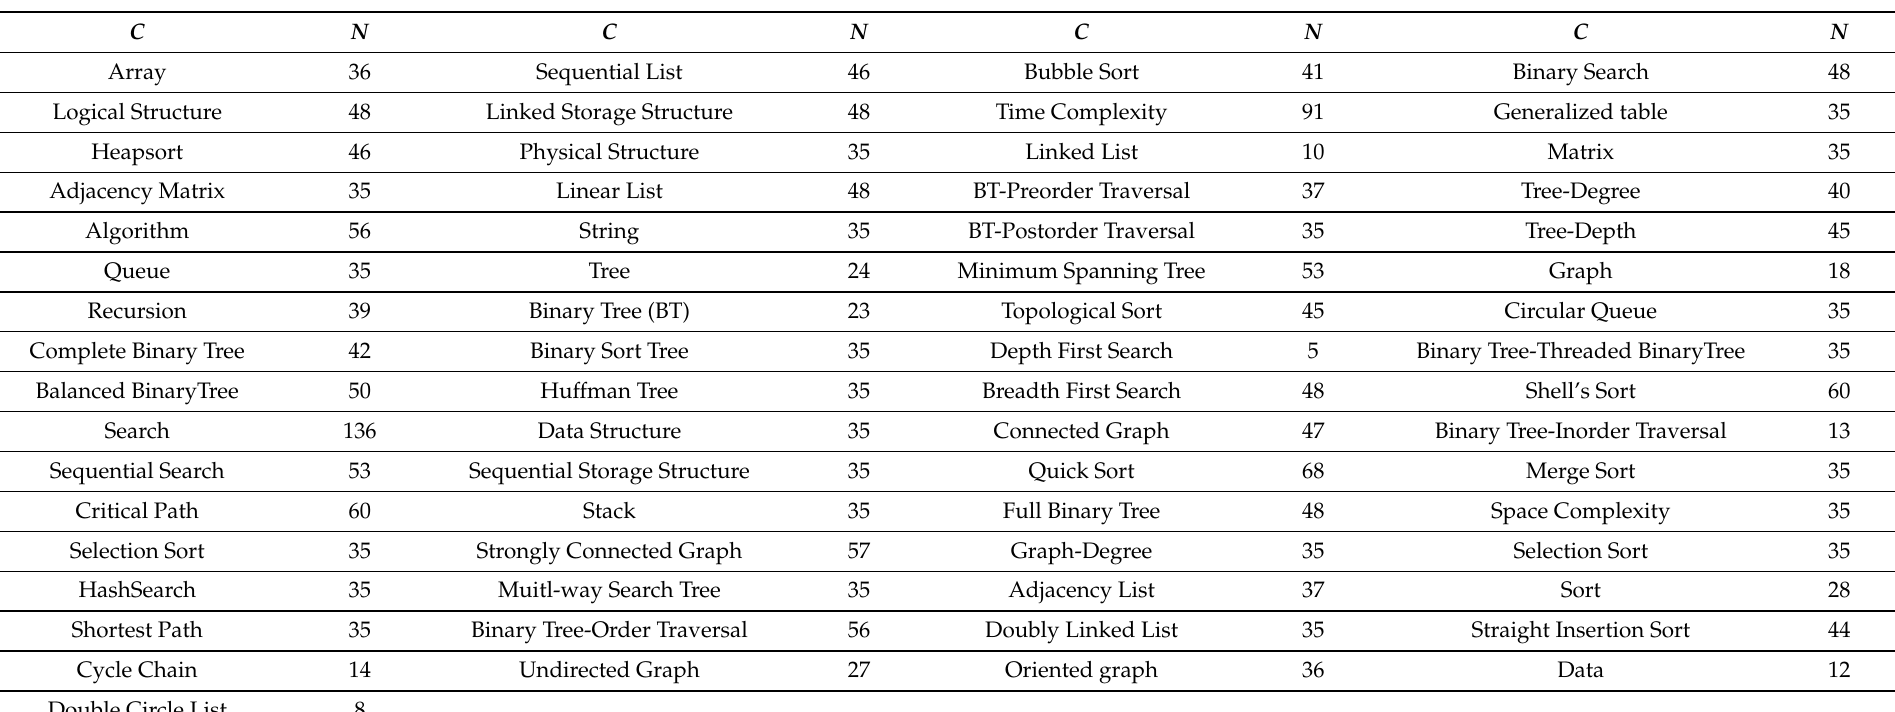
Table 1. The number of each exercise linking to knowledge concepts. C represents the label of the knowledge concept, N denotes the number of